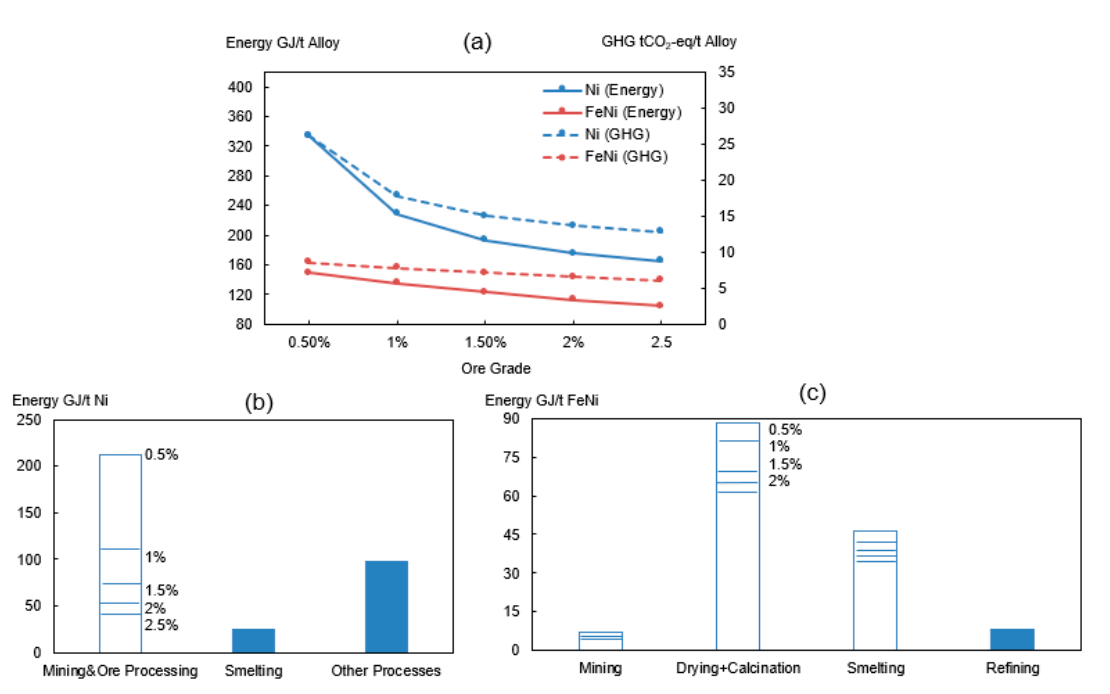
Figure 4. ( a ) Effect of ore grade on total energy consumption and GHG emissions of Ni (Blue) and FeNi (Red). Effect of ore grade on energy consumption of sub-process for production of ( b ) nickel metal and ( c ) FeNi.